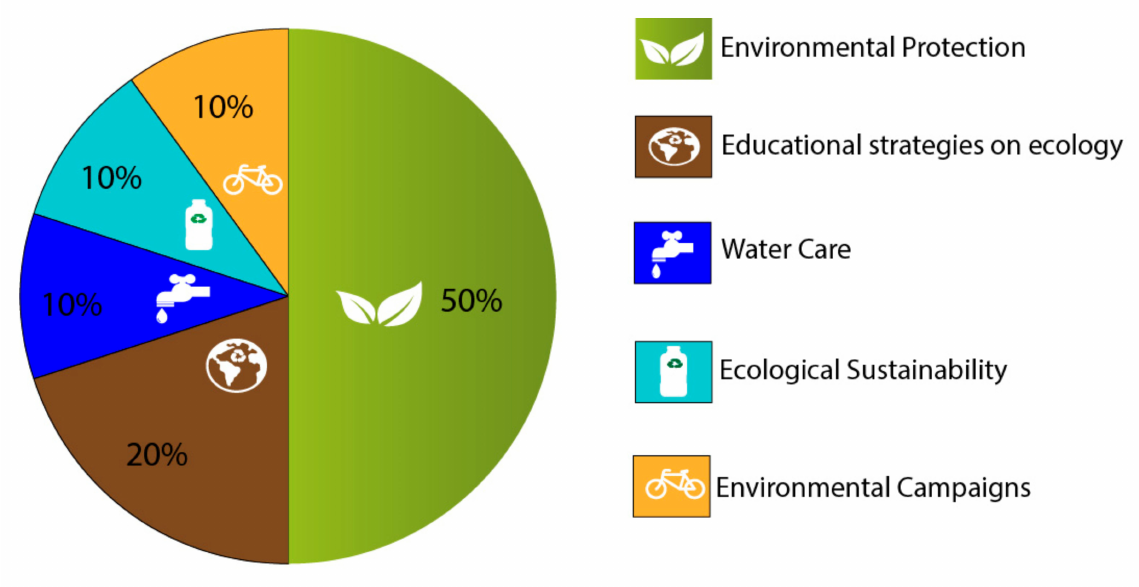
Figure 1. Applications aimed at